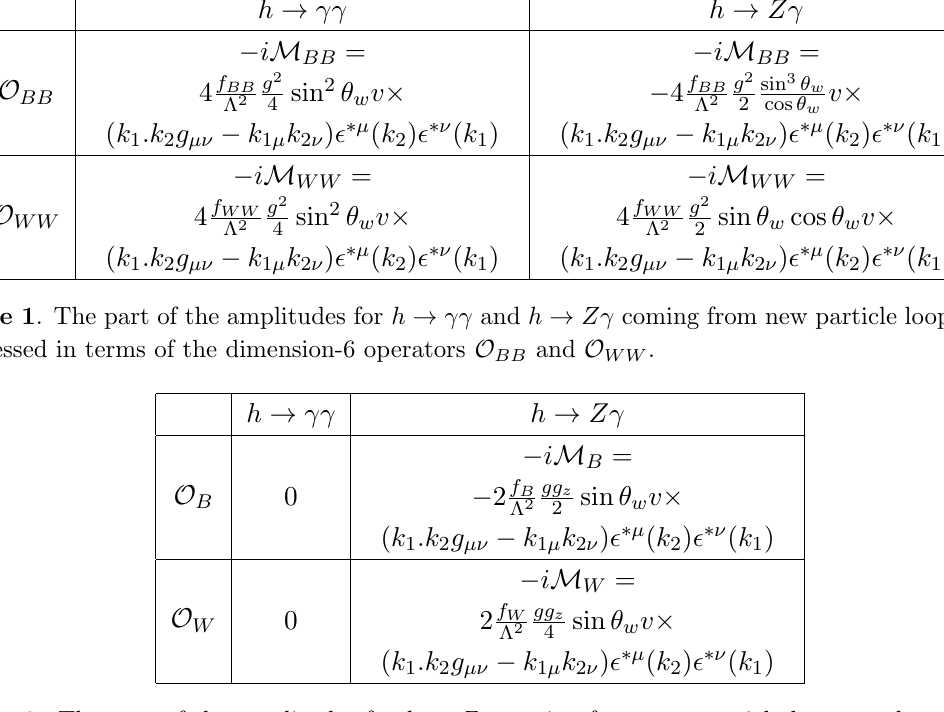
Table 2 . The part of the amplitudes for h ! Z(cid:13) coming from new particle loops, and expressed in terms of the dimension-6 operators O B and O W